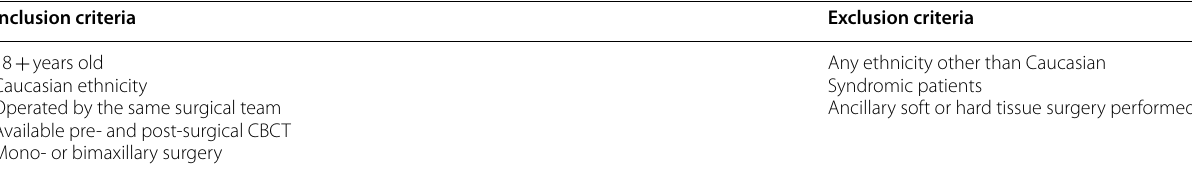
Table 1 Inclusion and exclusion criteria Inclusion criteria Exclusion